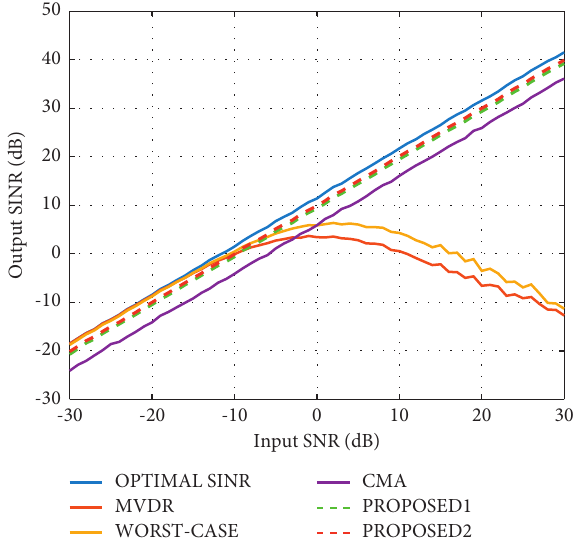
Figure 11: Random SV mismatch: output SINR versus the input SNR.